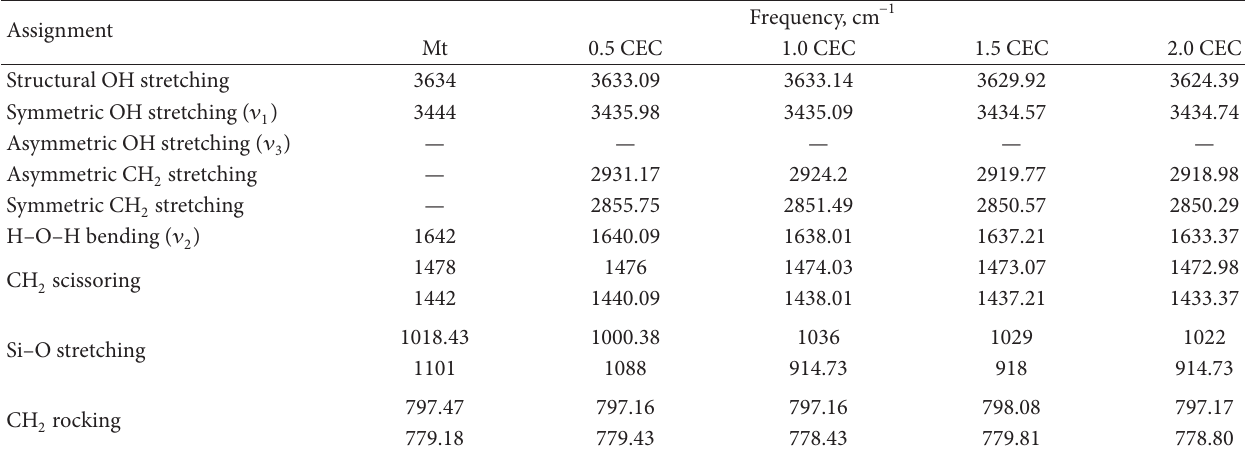
T 4: Positions and assignments of the IR vibration bands observed in the range of